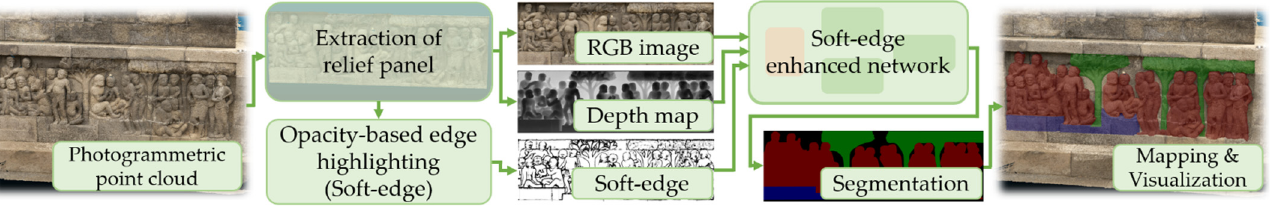
Figure 3. Block diagram: The first step is to extract the relief panel from the input and project the RGB image and depth map. Then, the soft edge is extracted by opacity-based edge highlighting. These images are transmitted to the soft-edge enhanced network as a multichannel to predict the two-dimensional semantic segmentation labels. Finally, the results are obtained by mapping the extracted semantic labels onto three-dimensional points of the relief data.